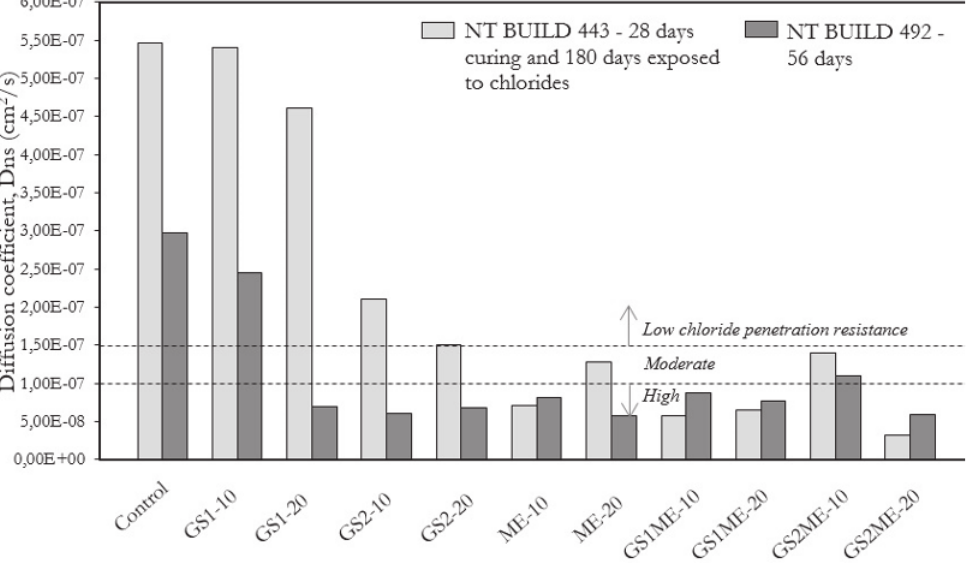
Chloride diffusion coefficient results as according to NT BUILD 443 and NT BUILD